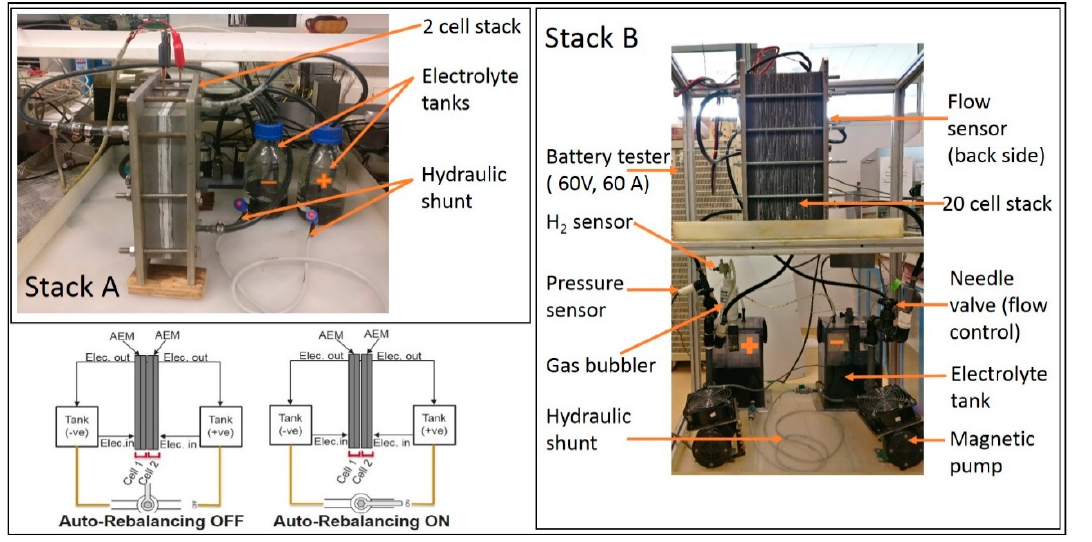
Figure 1. Test setups used for hydraulic shunt measurement.